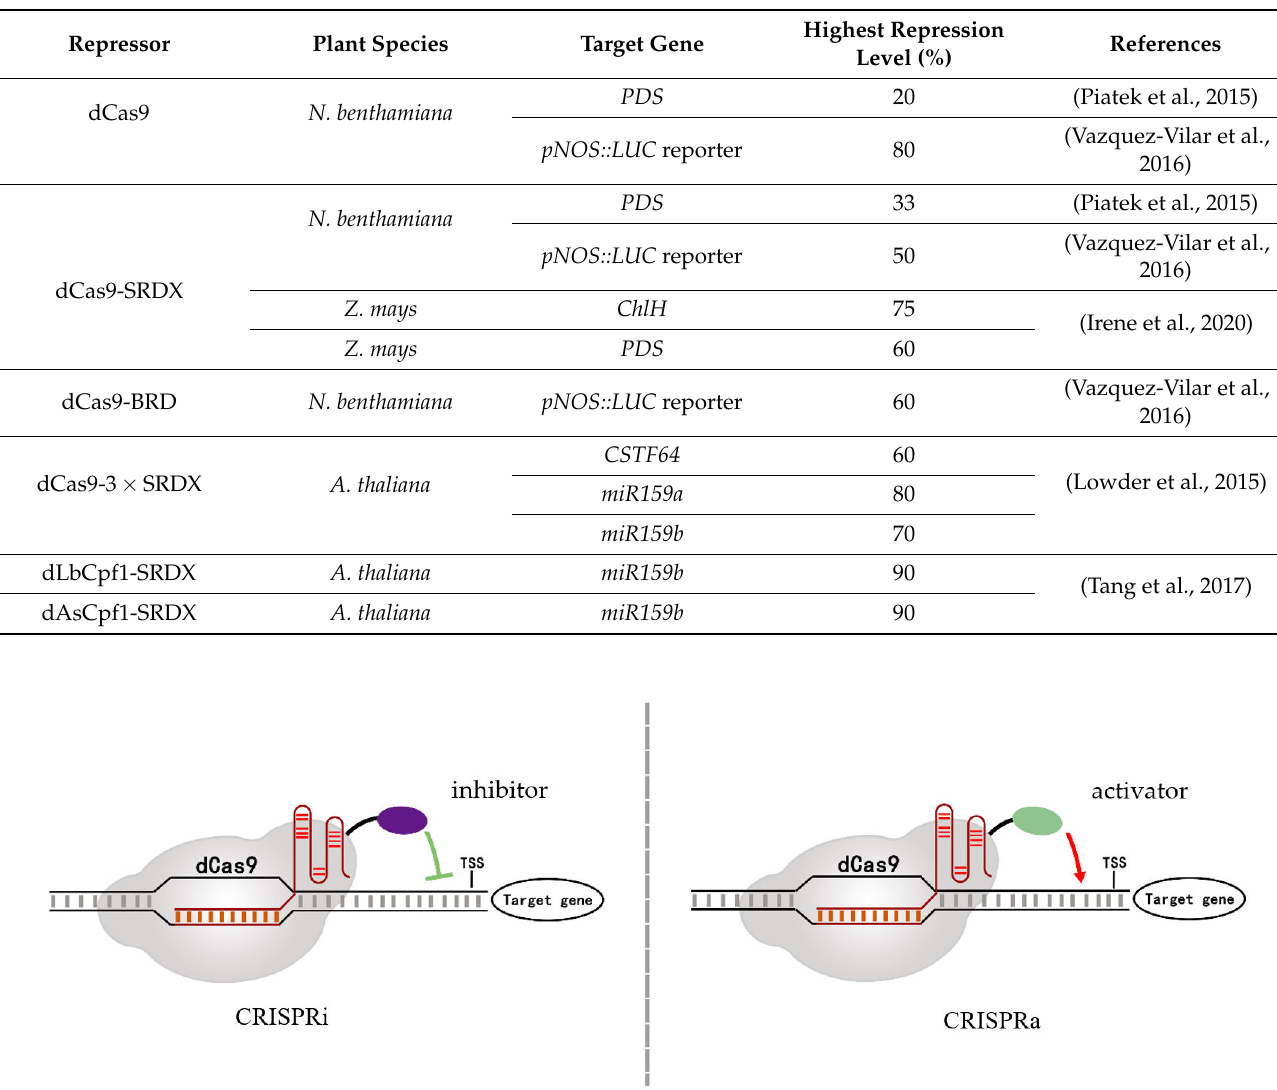
Table 1. Applications of CRISPR interference in plants.